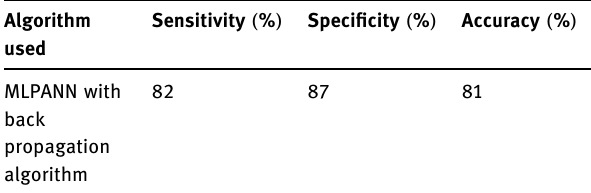
Table 8: Result of analysis